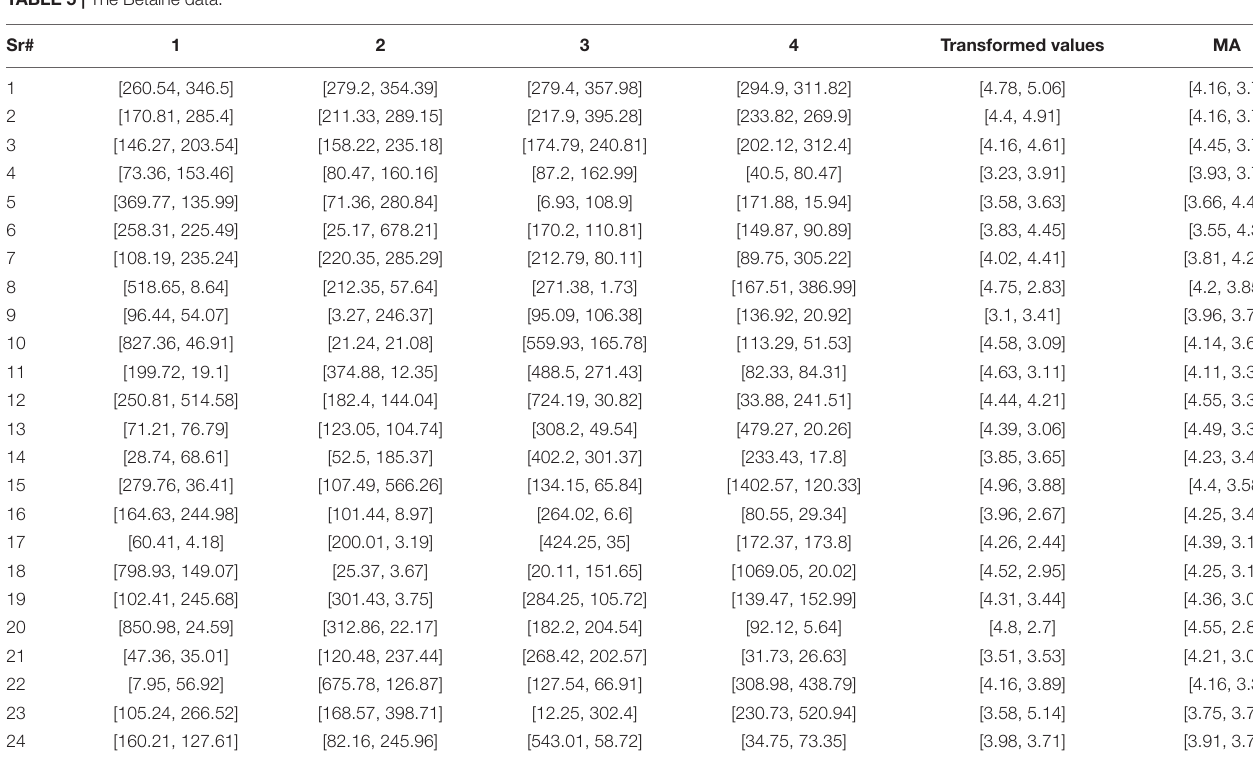
FIGURE 2 | The proposed chart and the existing chart for Betaine data. TABLE 5 | The Betaine